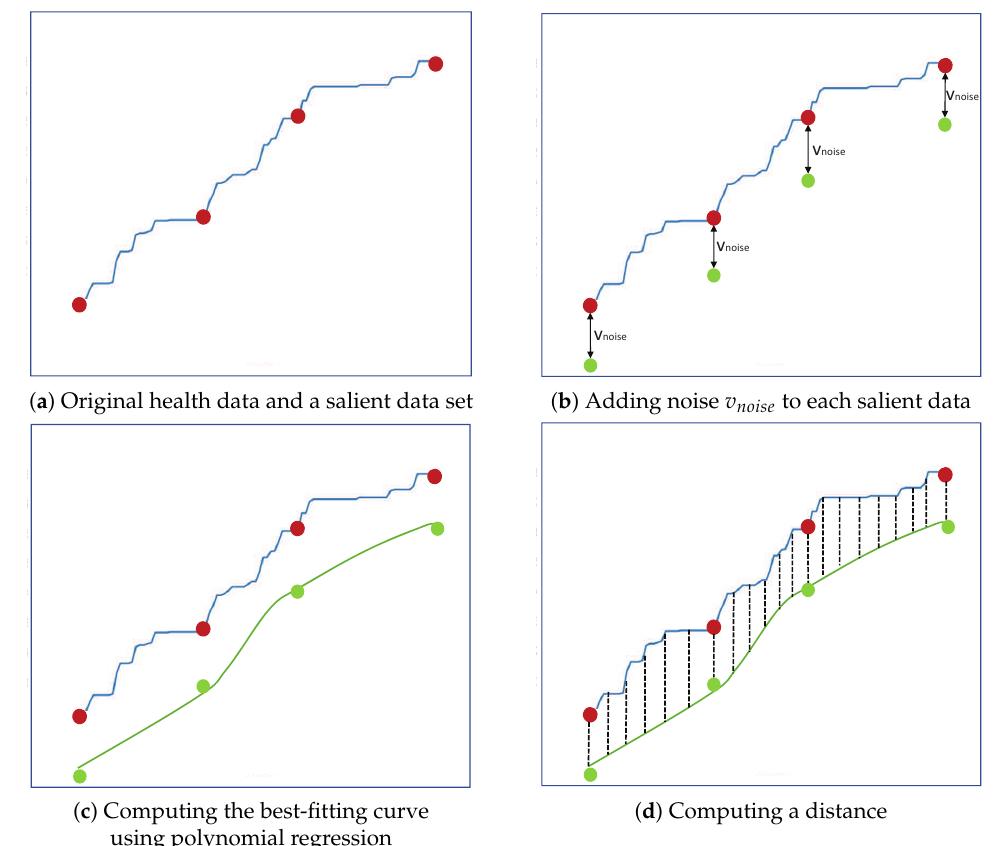
Figure 3. Example of computing the error by the function